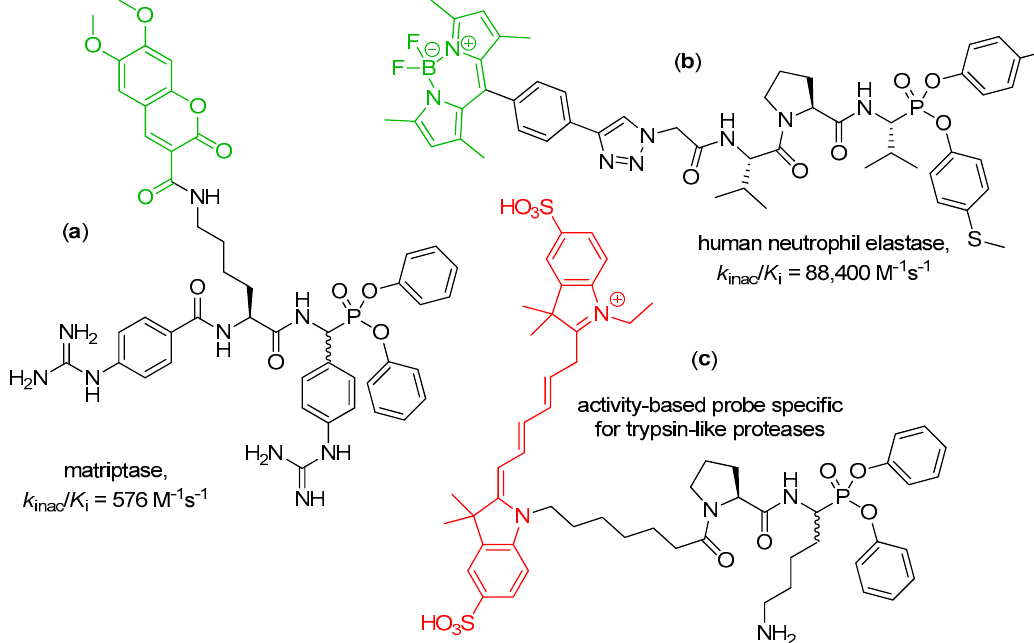
Figure 1. A selection of fluorescently labelled phosphonylating inhibitors for detection of serine protease: a coumarin-based probe for matriptase ( a ), a BODIPY probe for human neutrophil elastase ( b ), and a cyanine-modified peptidyl diphenyl phosphonate specific for trypsin-like proteases ( c ).